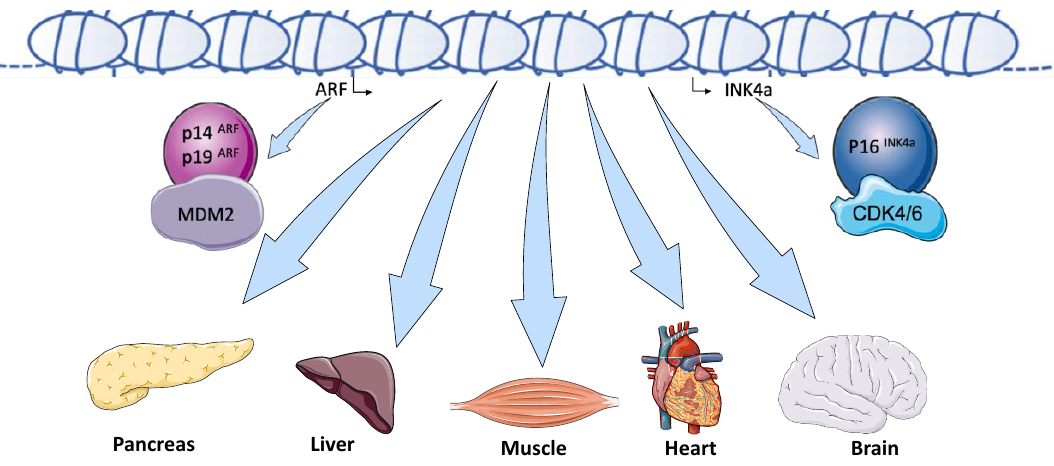
Figure 4. The INK4a / ARF locus: an emerging key actor in metabolic functions. In addition to AT, the INK4A / ARF ( CDKN2A ) locus is thought to play a variety of role in metabolic functions under normal and physiopathological conditions in other organs (pancreas, liver, muscle, heart, and brain). This locus a ff ects glucose homeostasis, β -cell functions and mass, hepatic gluconeogenesis and lipid storage as well as cardiovascular functions. It also regulates the circadian rhythm, neurogenesis, and axonal regeneration.